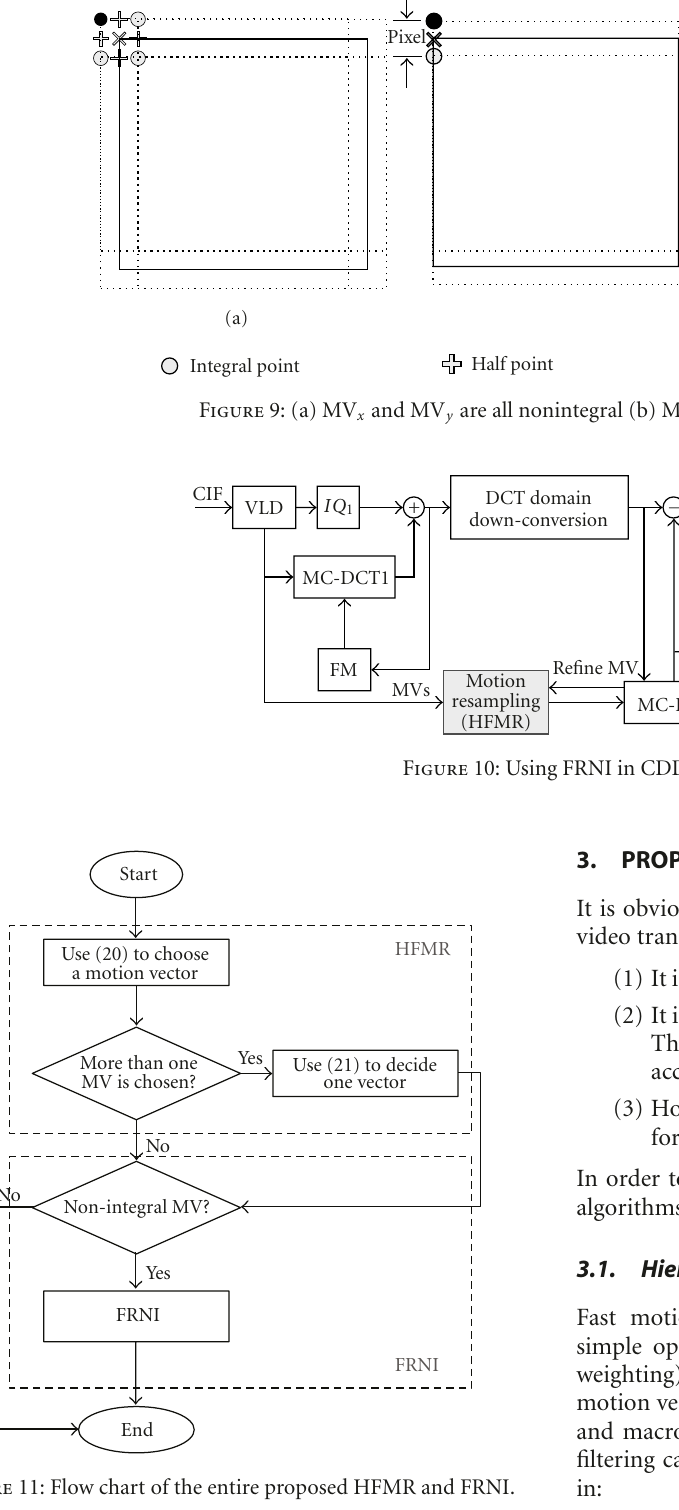
can apply refinement with fewer point (compared with traditional refinement), it is thereby referred to as fast search